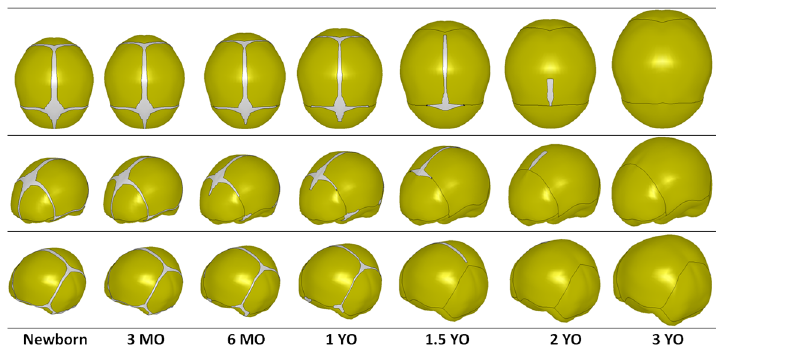
Fig 6. Skull size/shape and suture changes by age.